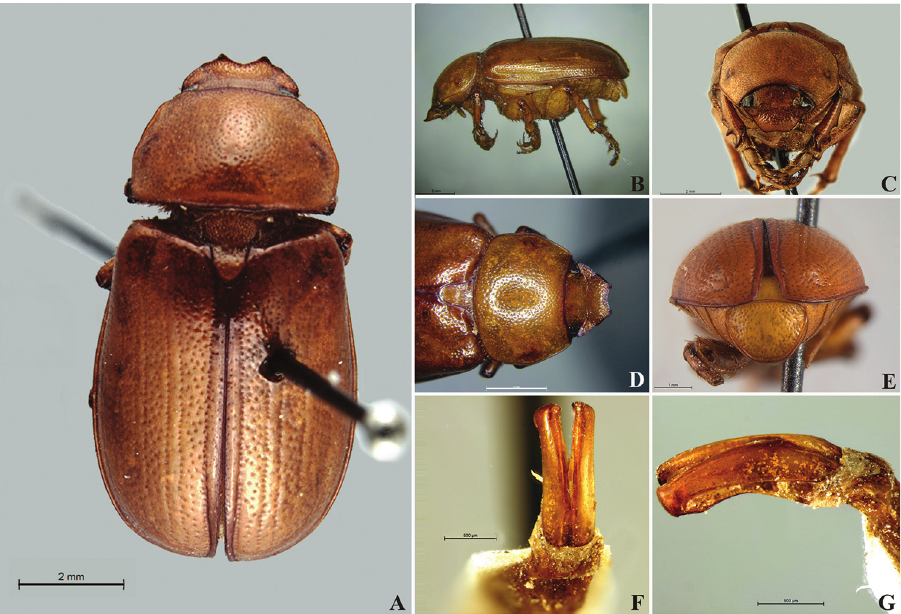
Figure 72. Liogenys sinuaticeps Moser. A Dorsal view B Lateral view C Frontal view D Clypeus and pronotum E Pygidium F Parameres, dorsal view G Parameres, lateral view. lum ogival, coarsely punctured at the base or sides. Elytra : shiny, glabrous,